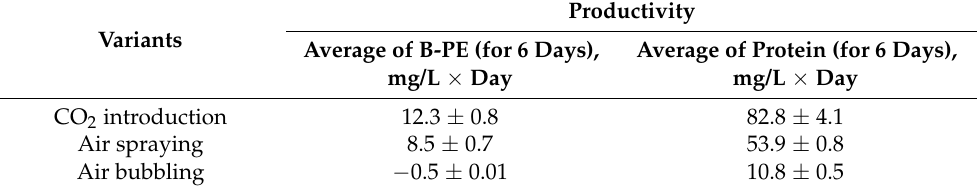
Table 2. The productivity characteristics of P. purpureum batch culture on B-PE and protein under the different methods of carbon introduction into photobioreactor (the values are means of three replicates ± ∆ x